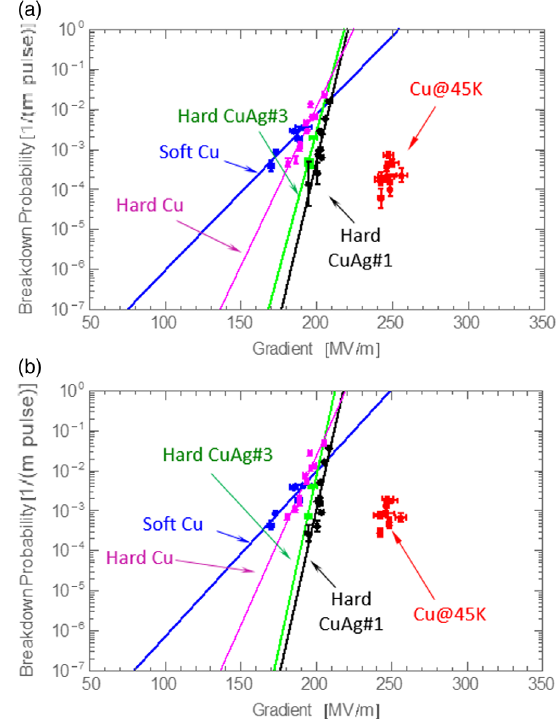
FIG. 11. Breakdown rate vs gradient:(a): first, trigger rf break- downs; (b): all rf breakdowns. For the breakdown probability ∼ 10 − 4 = pulse = m cryogenic structure clearly outperforms record data from hard CuAg